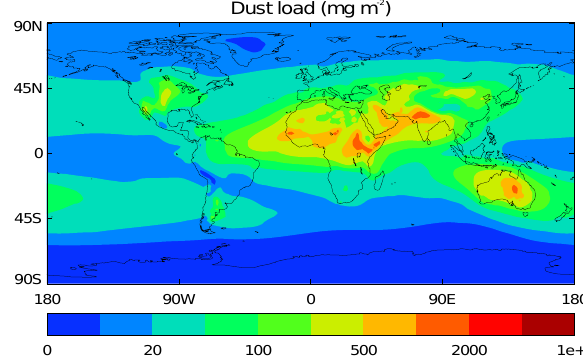
Fig. 9. Modelled decadal mean dust load in HadGEM2-ES for 1991–2000.